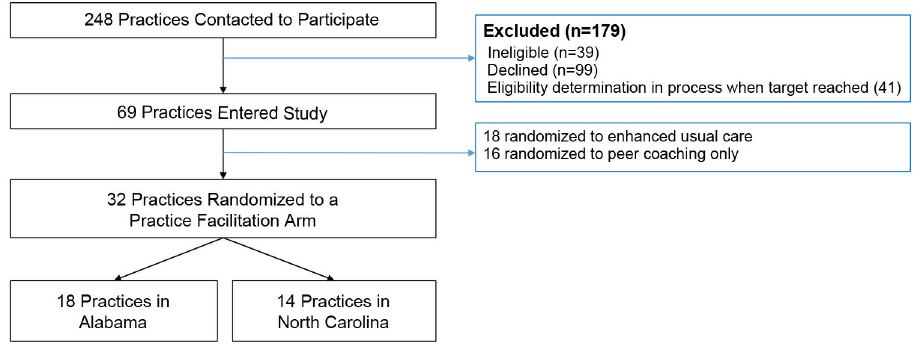
Fig 1. SEC trial CONSORT diagram for primary care